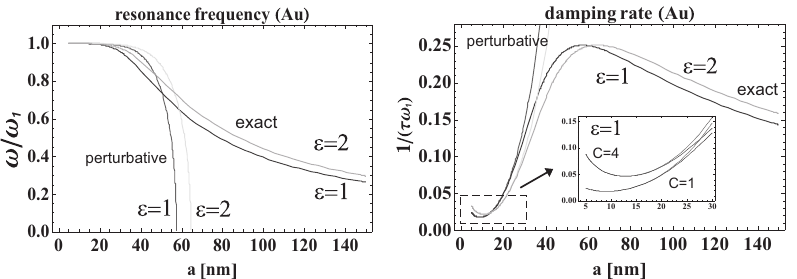
Figure 2. Resonant frequency of dipole mode of surface plasmons versus the metallic (Au) nanoparticle radius (left panel). Damping rate of dipole plasmon mode versus nanoparticle radius (right panel) – the maximum of damping at the ’plasmonic size’, of ca. 50 nm nanoparticle radius for Au, is pronounced as caused by giant Lorentz friction at this scale of spatial confinement. The resonant frequency and the damping rate of dipole surface plasmons (visualized in the figure) evidence that plasmons are not harmonic oscillators, they oscillate even at extremely strong damping without over-damped regime, which terminates harmonic oscillations (as shown in figure as perturbation solutions in contrary to exact ones including Lorentz fiction). For comparison two situations are presented – Au nanoparticles in vacuum ( ε = 1) and a dielectric surroundings with other value of dielectric susceptibility.